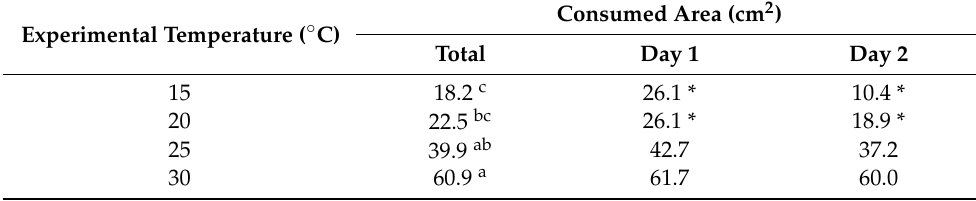
Table 1. Differences in food consumption at different temperature conditions. Different letters (a, b, c) indicate significant differences between treatments based on Dunn’s multiple comparison test ( p < 0.05).